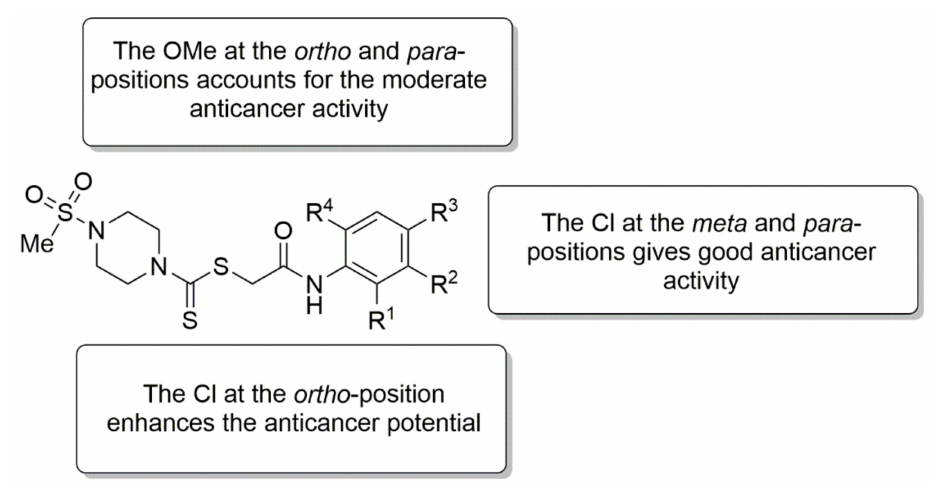
Figure 5. SAR summary.